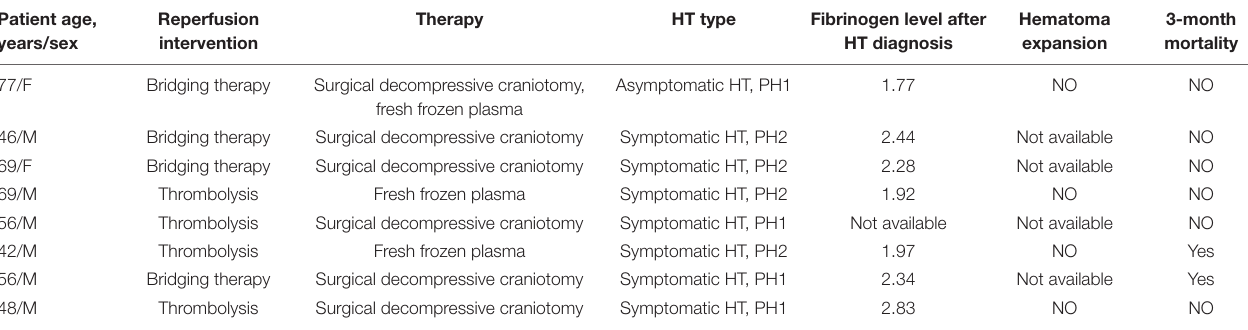
TABLE 3 | The characteristics and outcomes of the patients received surgery or fresh frozen plasma ( n =